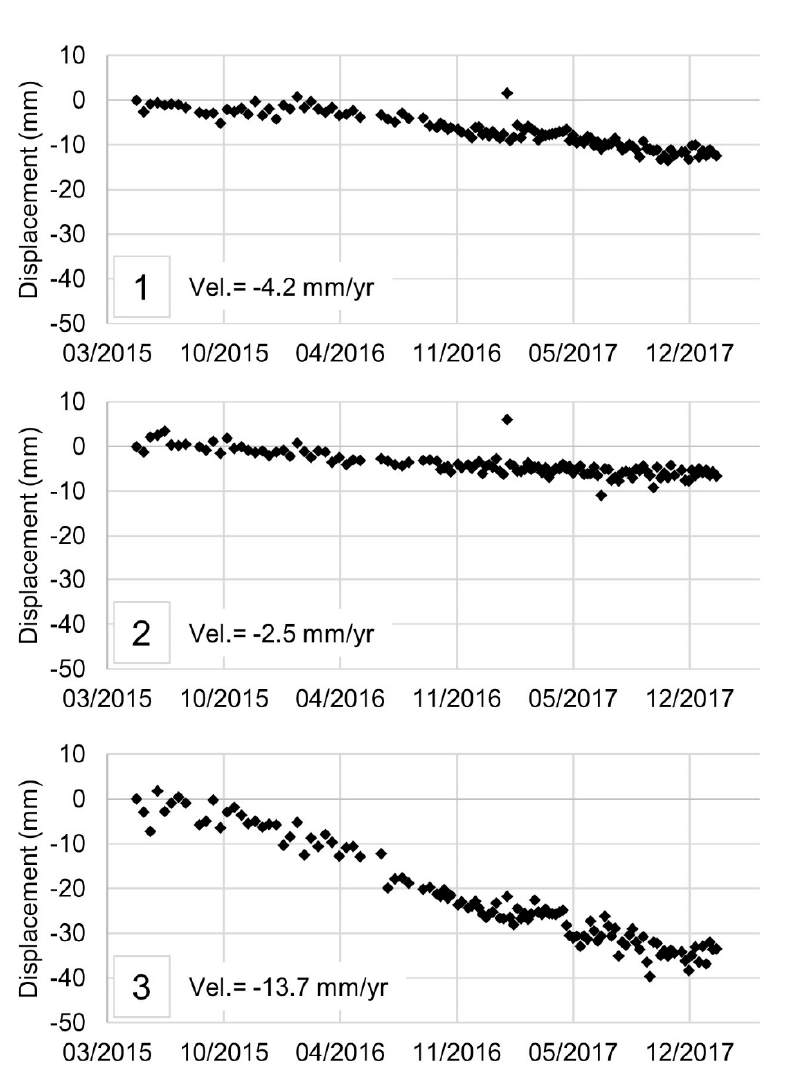
Figure 19. Displacement time series extracted for the points selected with the white circles in AOI-2. ( 1 ) south-west section of the mine site; ( 2 ) main mine site; ( 3 ) Tailing Storage Facility (TSF) site. See Figure 17 for point locations.